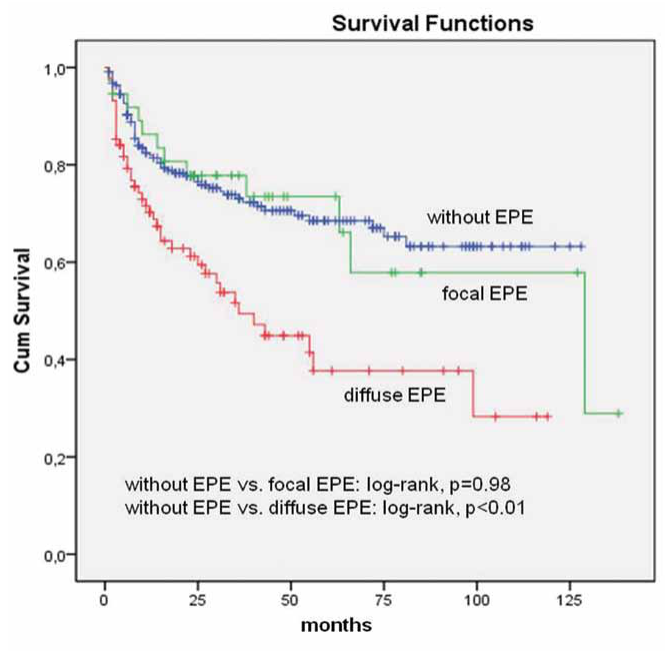
Figure 2 - Kaplan-Meier biochemical (PSA) progression-free survival curve comparing 219 surgical specimens without EPE vs 37 surgical specimens with focal EPE (Group 1), and 88 surgical specimens with diffuse EPE (Group 2).